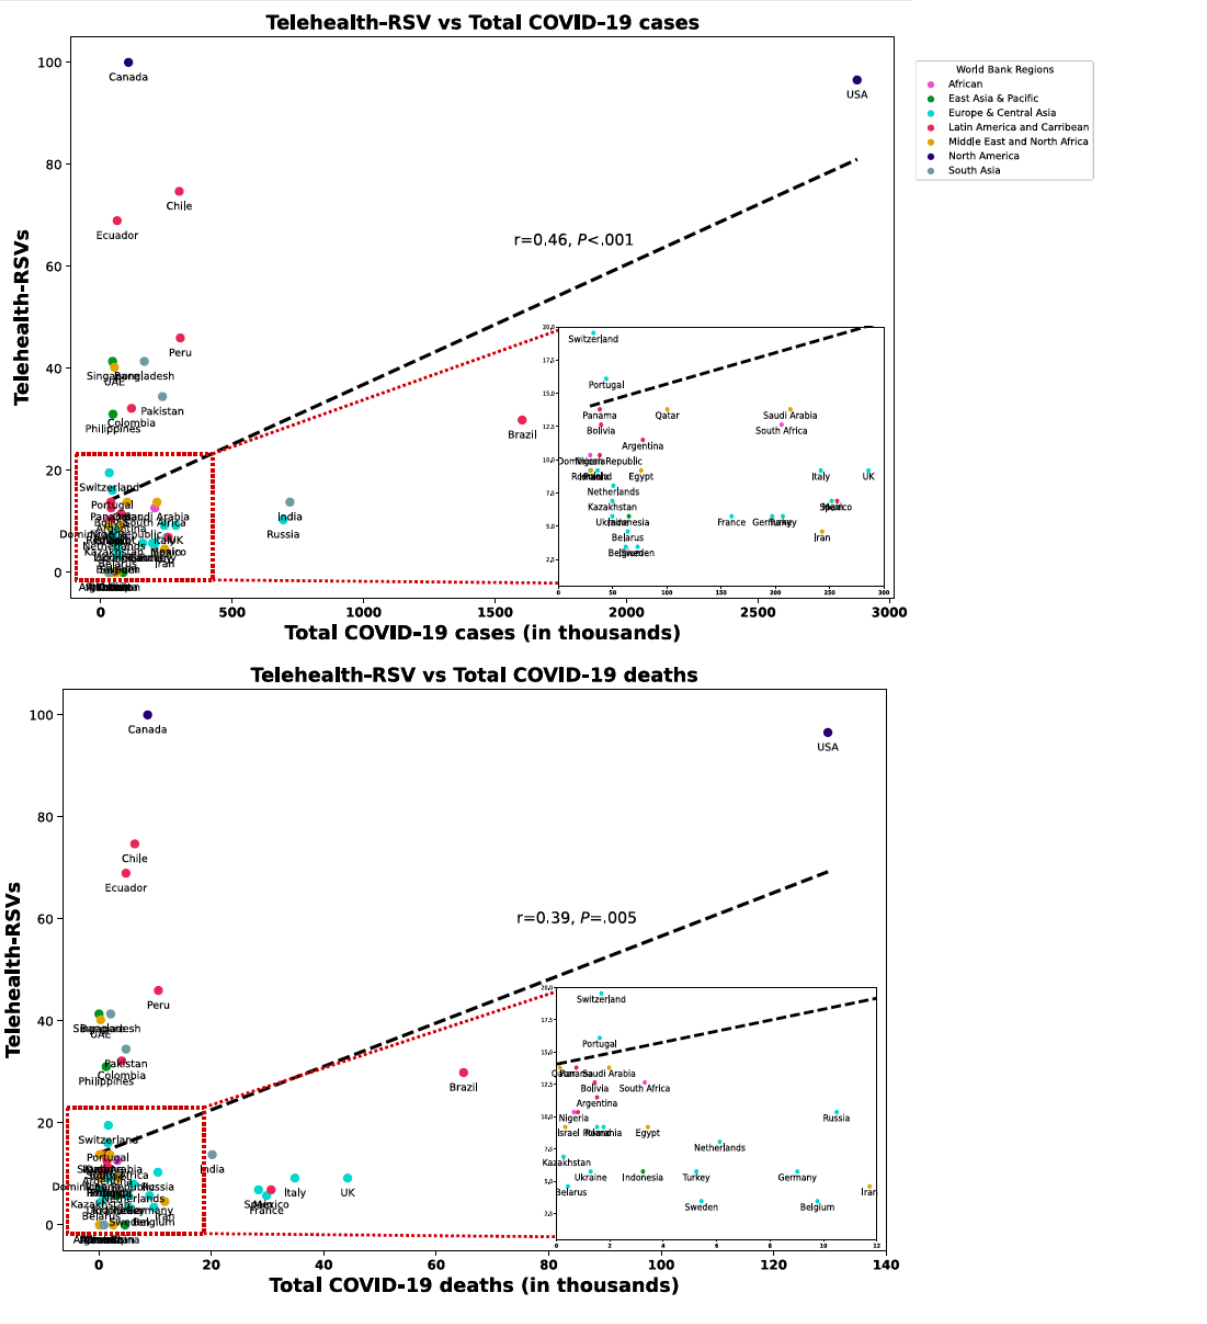
Figure 3 depicts the overall worldwide trends in telehealth-related RSVs during the study period, on a backdrop of accumulated COVID-19 cases and deaths. A surge in RSV levels can be observed from March 11, 2020, the date when the WHO officially declared the COVID-19 outbreak a pandemic, and culminates with an observed peak (RSV=76.0) in telehealth-RSV levels on March 24, 2020, with more than 10 times the pre–COVID-19 levels (mean 7.29). RSV levels then tailed off in June-July 2020 (mean 25.8) but still remained higher than pre–COVID-19 levels. For comparison, another curve representing RSVs for a search of “coronavirus” (in blue) was plotted alongside the telehealth-RSV curve (in red). The coronavirus-related RSVs demonstrated a similar trend—a sharp spike near March 11 and peaking on March